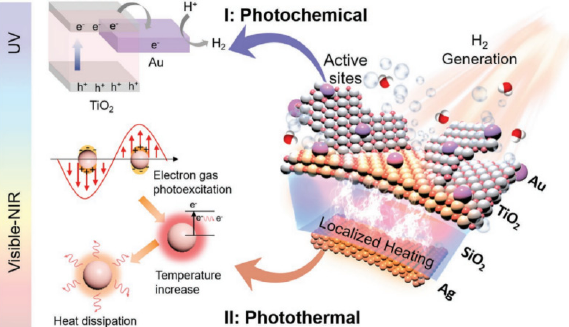
Figure 12. The schematic diagram illustrates the mechanism for enhanced photocatalytic H 2 gener- ation due to photothermal and photochemical effects (Reprinted/adapted with permission from